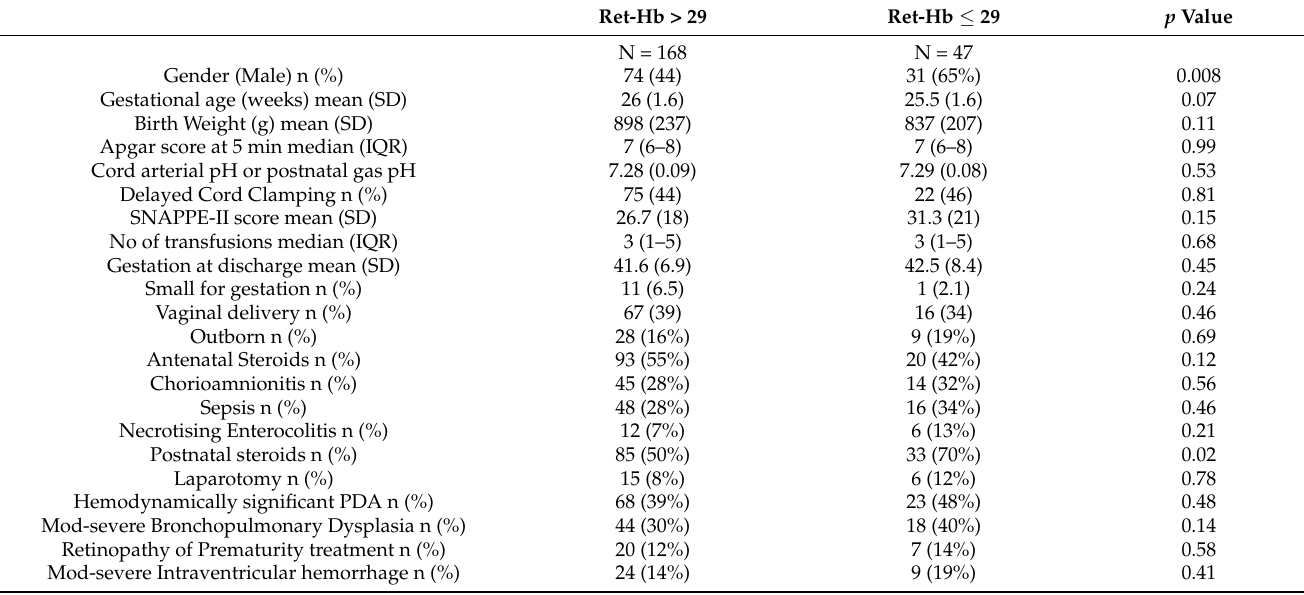
Table 1. Perinatal characteristics of neonates with and without iron limited erythropoiesis at 36 weeks corrected gestational